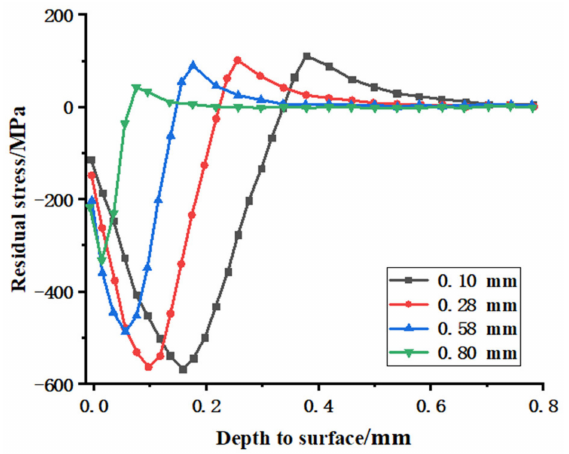
Figure 6. Influence of shot size on residual stress distribution